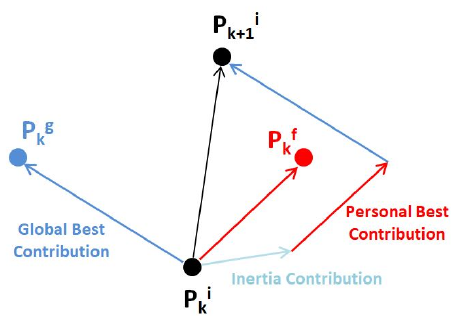
Figure 5. Illustration of PSO algorithm principles and mathematical description.